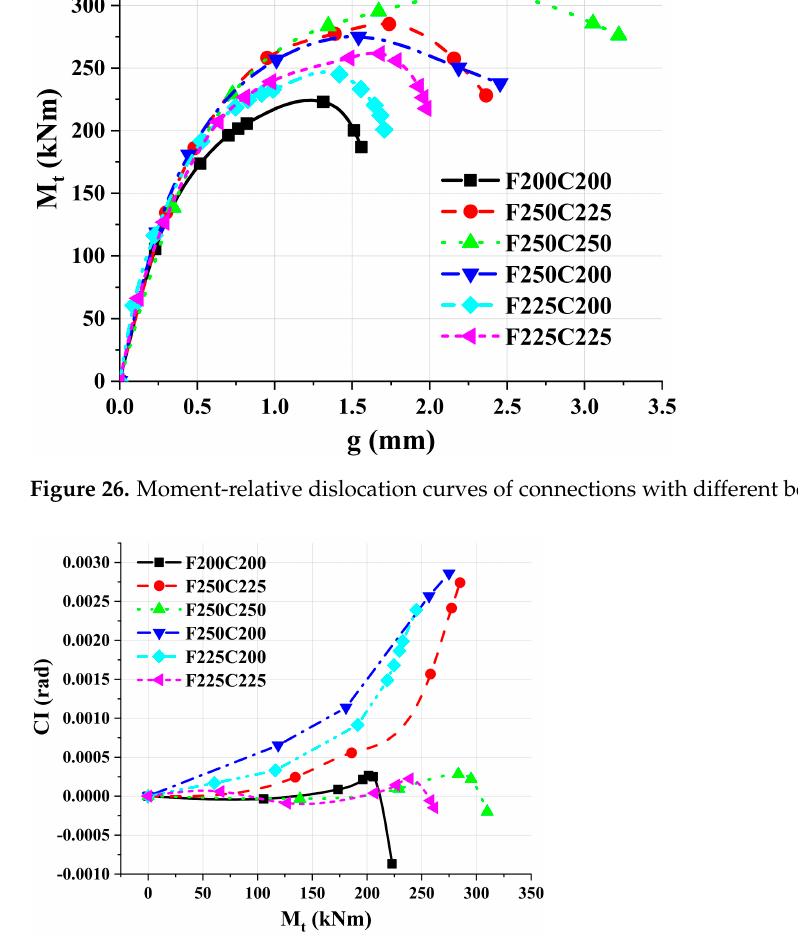
Figure 27. Continuity index-moment curves of connections with different beam